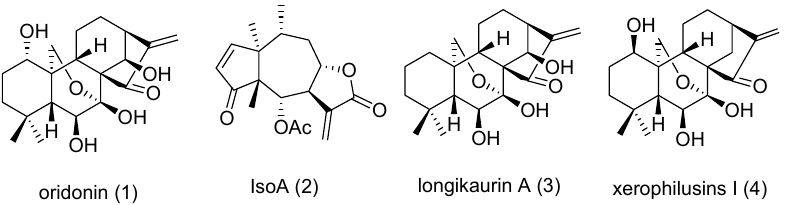
Figure 1. Structures of ent -Kaurane-type diterpenoids.